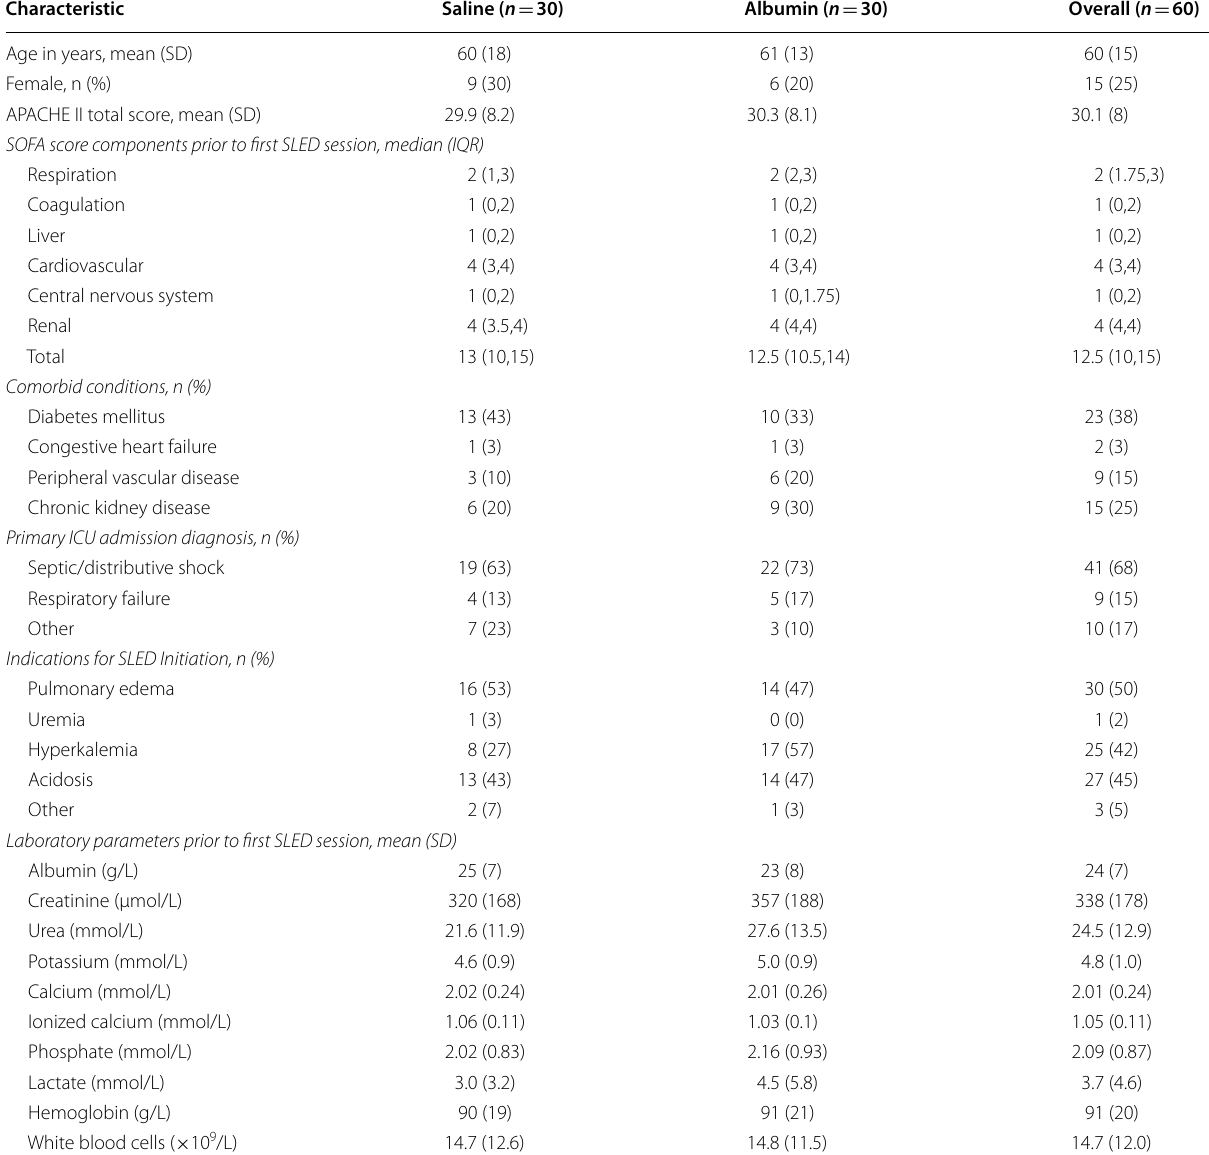
Table 1 Baseline characteristics of included patients (prior to first SLED session)